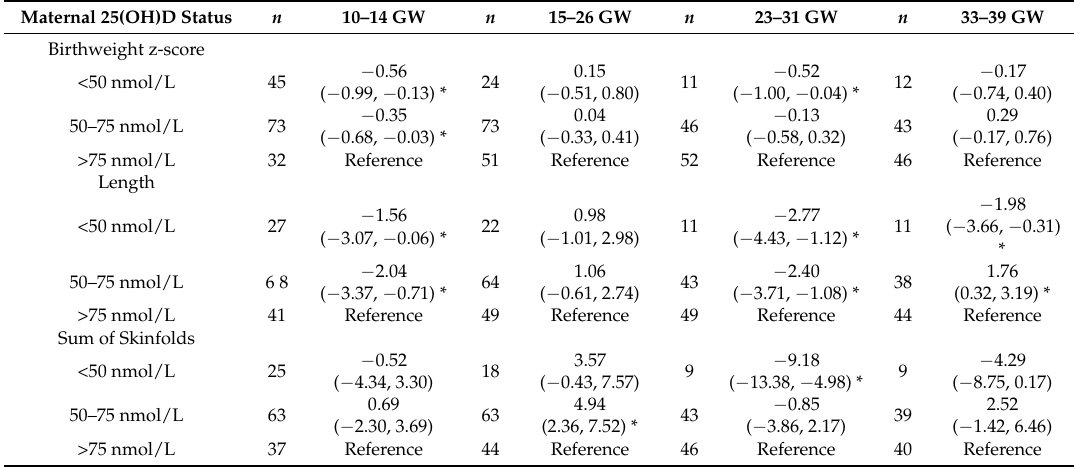
1 Data are presented as regression coefficients and confidence intervals (CI) and reflect the differences in neonatal anthropometry compared to the reference group (25(OH)D >75 nom/L). All models are adjusted for maternal matching characteristics (age (continuous), race, and gestational age at blood collection), and adjusted for education, insurance type, marital status, and prepregnancy BMI (continuous). Models of sum of skinfolds were adjusted to account for the difference in days between birth and date of anthropometric measurement. * ( p -value <